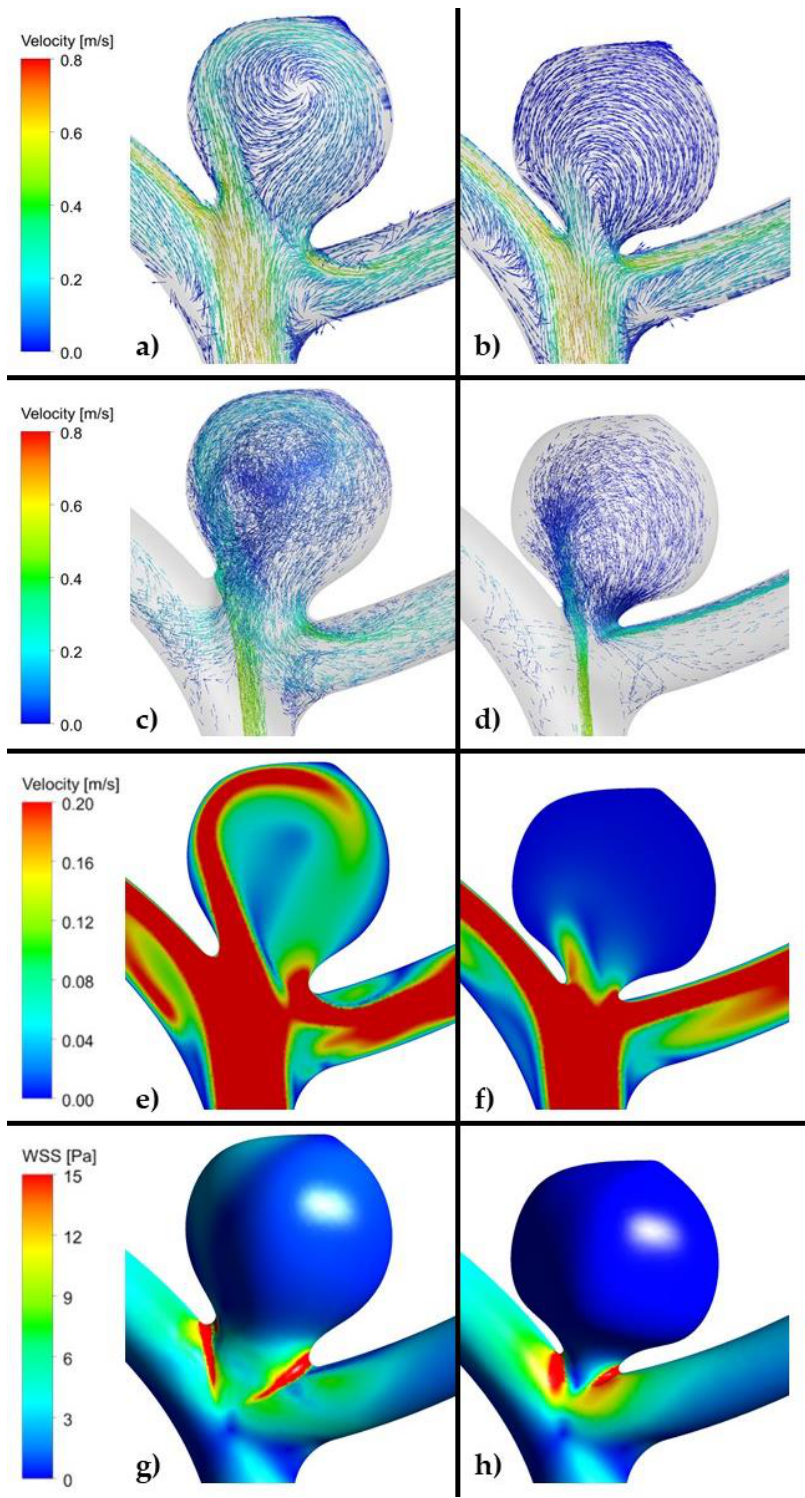
Figure 5. ( a , c , e , g ). Example of high risk recanalization aneurysm model (unruptured group). Flow pattern analysis demonstrates a complex vortex structure. WSS analysis demonstrates heterogenous wall shear stress with an area of the aneurysm dome under high shear stress. ( b , d , f , h ). Example of low risk recanalization aneurysm model (unruptured group). Flow pattern analysis demonstrates a simple vortex structure. WSS analysis demonstrates heterogenous wall shear stress with an area of the aneurysm dome under low shear stress. (ANSYS Inc. Post-processing module, Canonsburg, PA, USA).